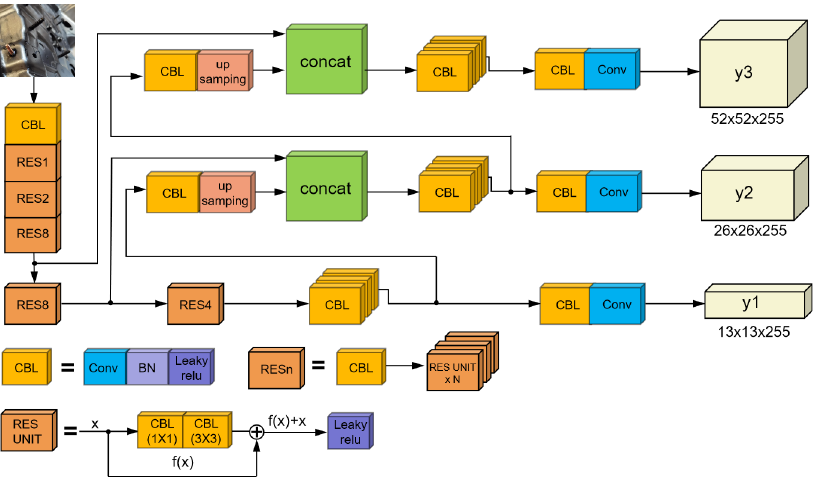
Figure 1. YOLOv3 algorithm network structure.